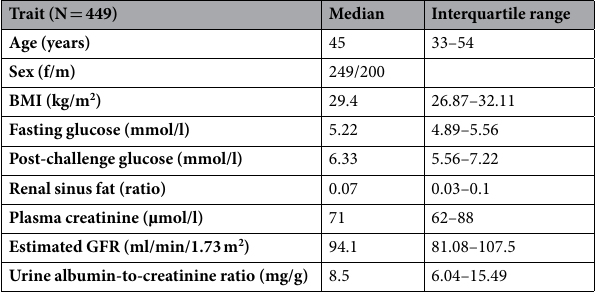
Table 1. Anthropometric and clinical data of the studied cohort interquartile